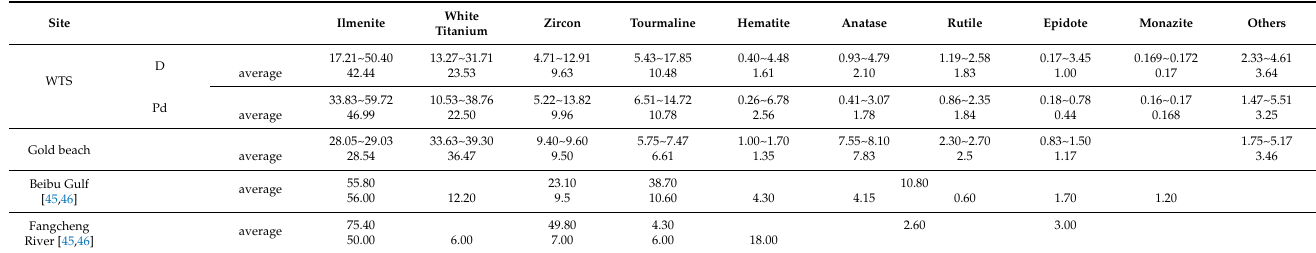
Table 3. Heavy mineral composition (%) in different sedimentary facies of the Wutou section. Site Ilmenite White Titanium